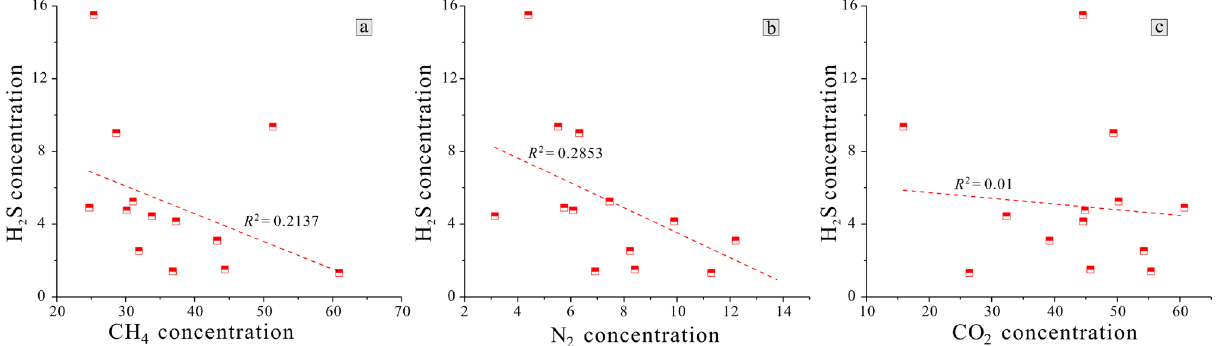
Figure 4. Correlation between gas composition and H 2 S concentration. ( a ) is the correlation of H 2 S concentration versus CH